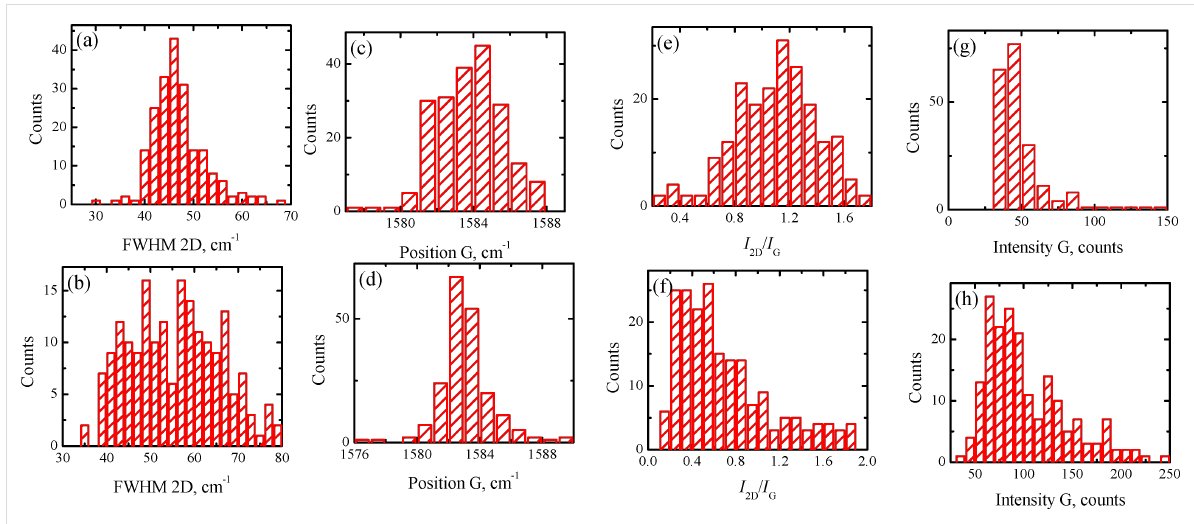
Figure 8: Replotted histograms of sample B on a SiO 2 /Si substrate for a laser excitation wavelength of 473 nm using the 2D-band position of 2712 cm − 1 as the partitioning criterion. (a) and (b) FWHM of the 2D band. (c) and (d) G-band position. (e) and (f) I 2D / I G ratio. (g) and (h) I G value. Data shown in (a), (c), (e) and (g) plots are for the 2D-band positions greater than 2712 cm − 1 . Data shown in (b), (d), (f) and (h) plots are for the 2D-band positions smaller than 2712 cm − 1 .